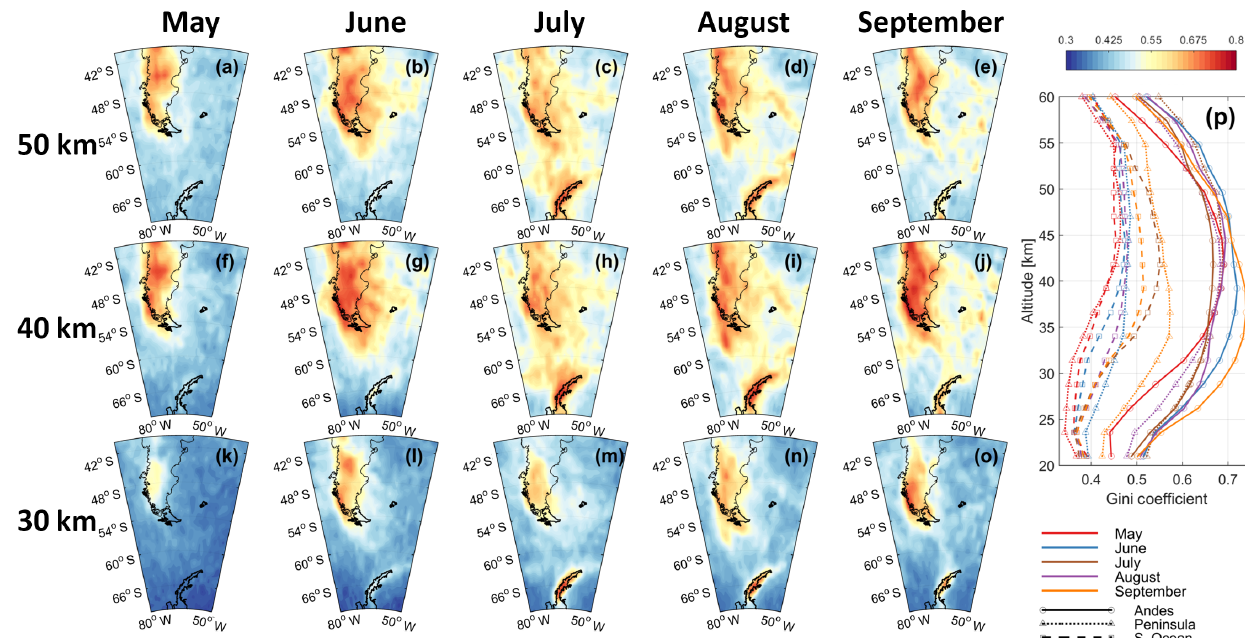
Figure 12. Gini coefficient G over the region of interest. (a–o) Maps of measured monthly G at (a–e) 50km (f–j) 40km (k–o) 30km altitude. (p) Height series of G for each month over the three regions defined in Fig.